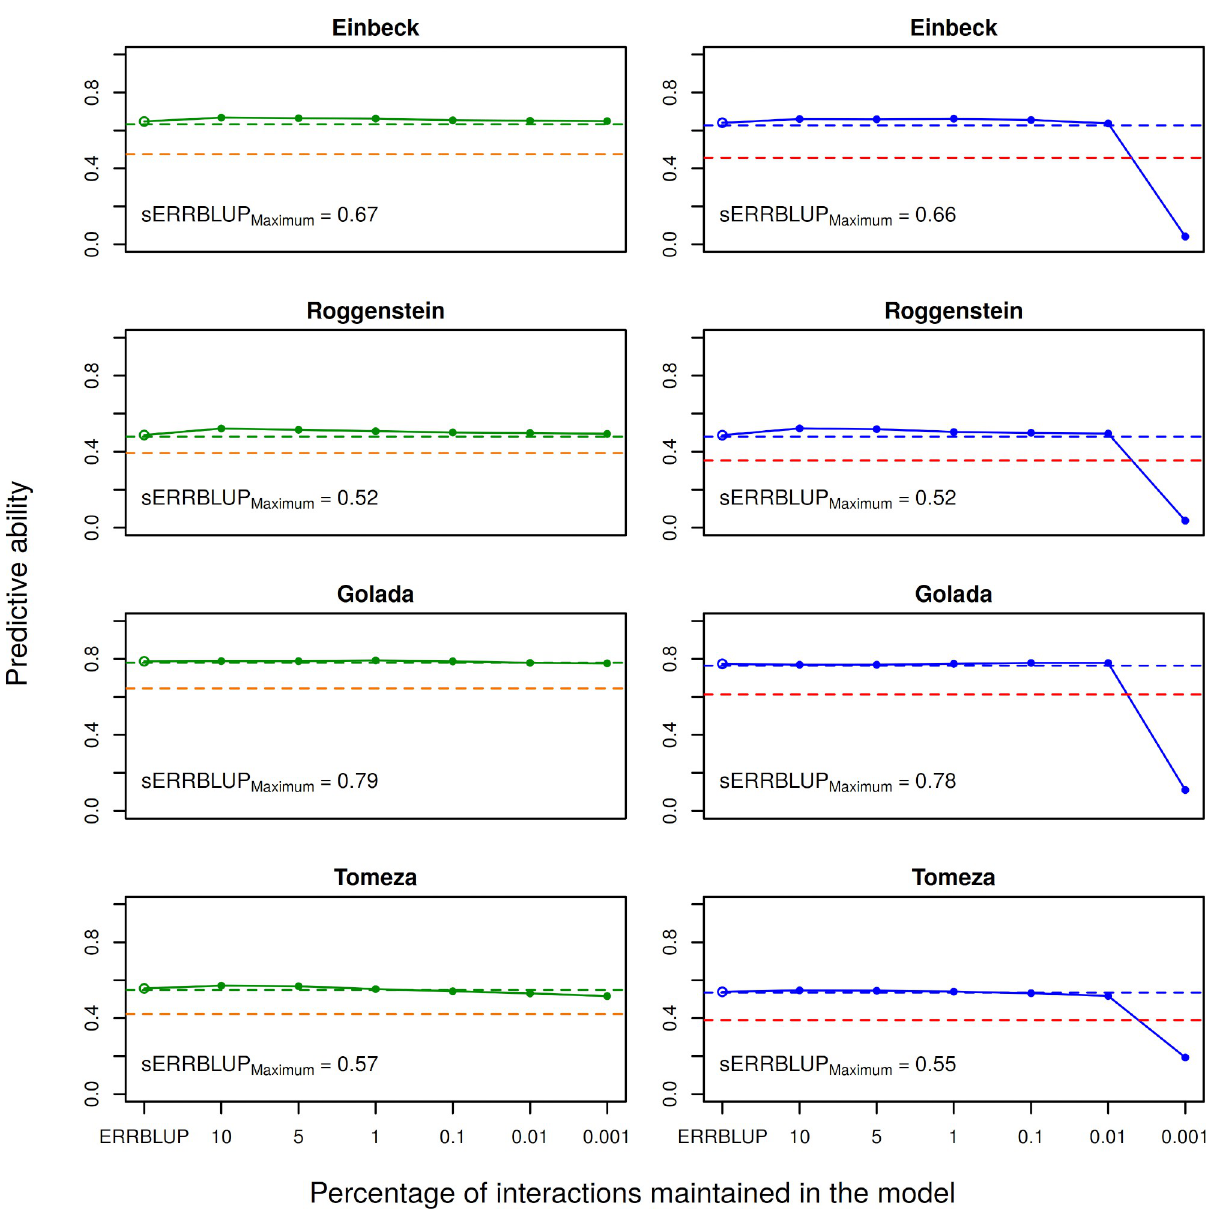
Fig 2. Predictive ability for univariate GBLUP within 2018 (orange and red dashed horizontal line), bivariate GBLUP (green and blue dashed horizontal line), bivariate ERRBLUP (open circle) and bivariate sERRBLUP (filled circles and solid line) for trait PH-V4 in Petkuser based on the pruned sets of SNPs (left) and haplotype blocks (right). In each plot, the sERRBLUP maximum indicates the maximum predictive ability obtained from bivariate sERRBLUP.